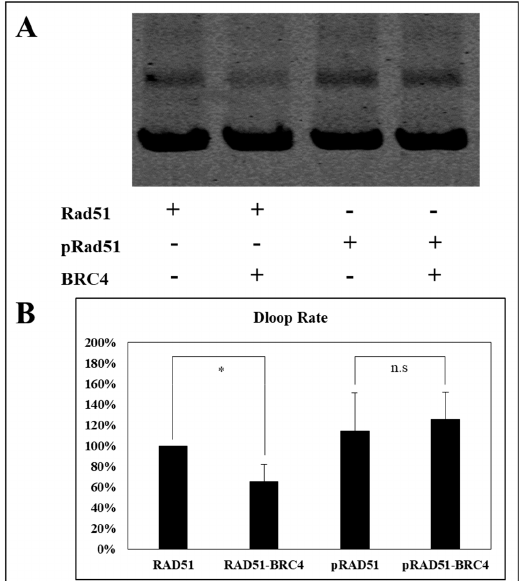
Figure 7. BRC4-mediated nucleofilament dissociation is less effective when RAD51 is phosphorylated. The RAD51 WT protein (10 µM) was purified and phosphorylated in vitro by